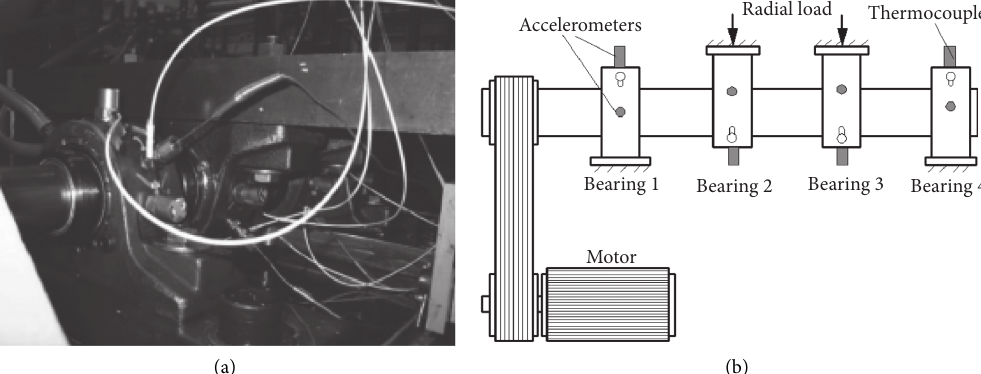
Figure 3: Bearing test platform. (a) Bearing test rig. (b) Sensor placement.